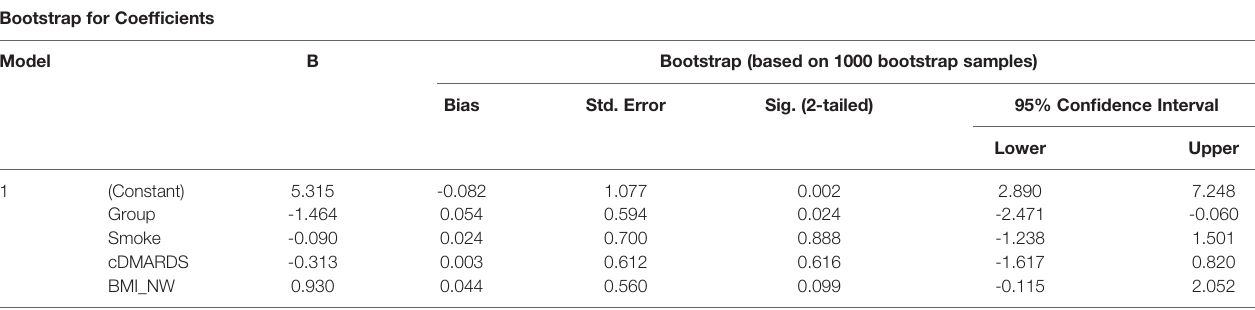
TABLE 4 | Bootstrapping analysis for pSTAT3 in CD14+CD16- monocytes. Bootstrap for Coef fi